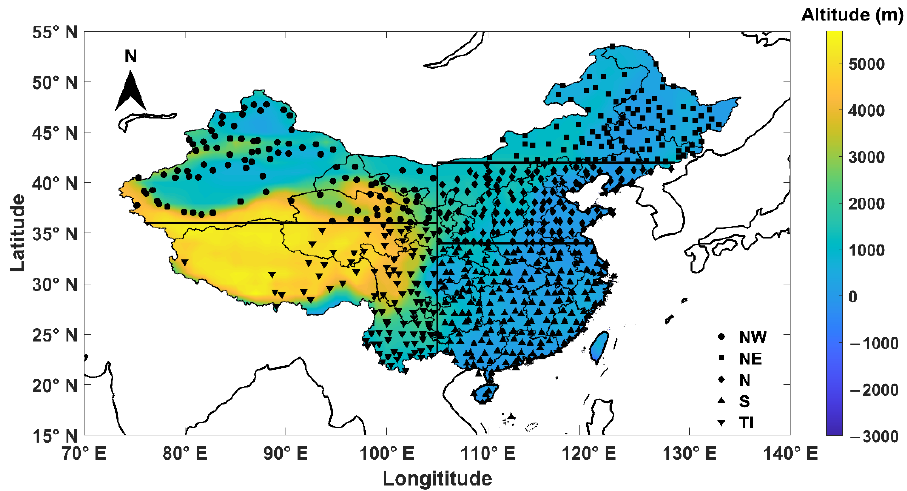
Figure 1. Spatial distribution of 635 ground weather stations used in this study and region classification. Five regions have been classified, which are Northwest China (NW), Tibetan Plateau (TP), Northeast China (NE), North China (N), and South China (S). The colors represent the ground altitude above sea level.